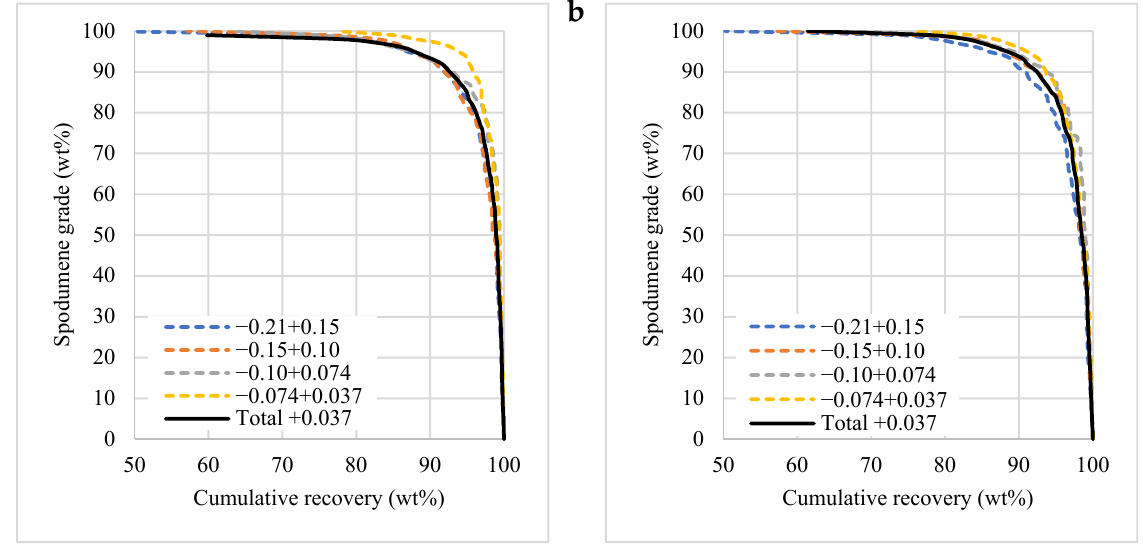
Figure 10. Theoretical grade recovery curves for spodumene in G1 ( a ) and G2 ( b ).